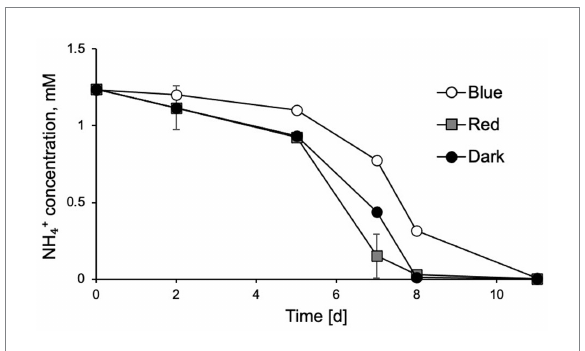
FIGURE 3 Exposure of N. inopinata to wavelengths of blue-green spectrum (450–550 nm) caused delayed ammonia oxidation in comparison to yellow-red spectrum (550–680 nm) wavelengths and dark control. Data are presented as the mean and standard error of triplicate cultures.